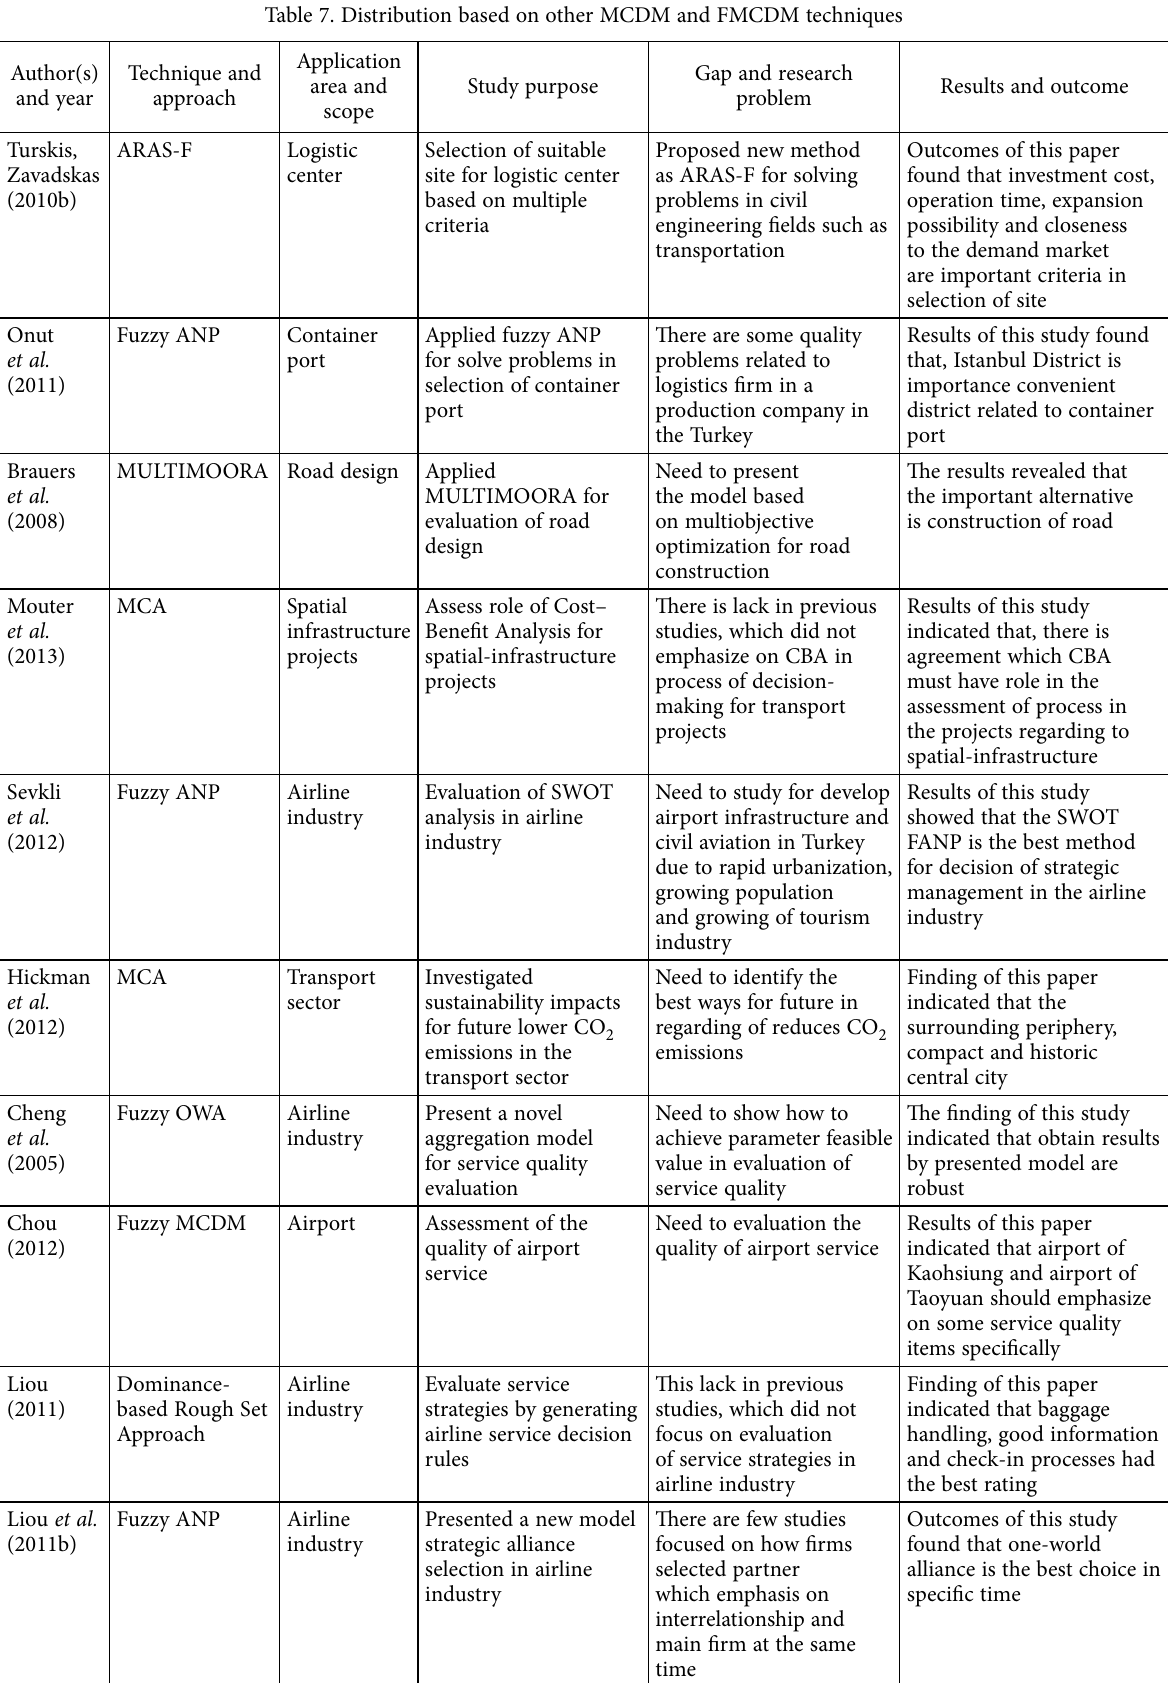
R Table 7. Distribution based on other MCDM and FMCDM